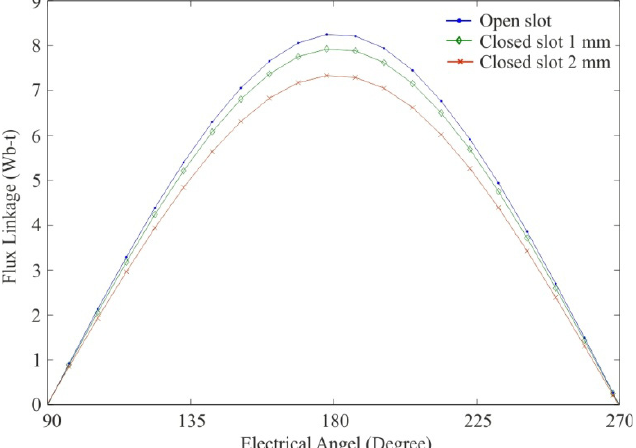
Figure 10. Flux linkage for one phase of the machine during 180 electrical degrees for: open slot (dot); closed slot 1 mm thick (diamond); and closed slot 2 mm thick